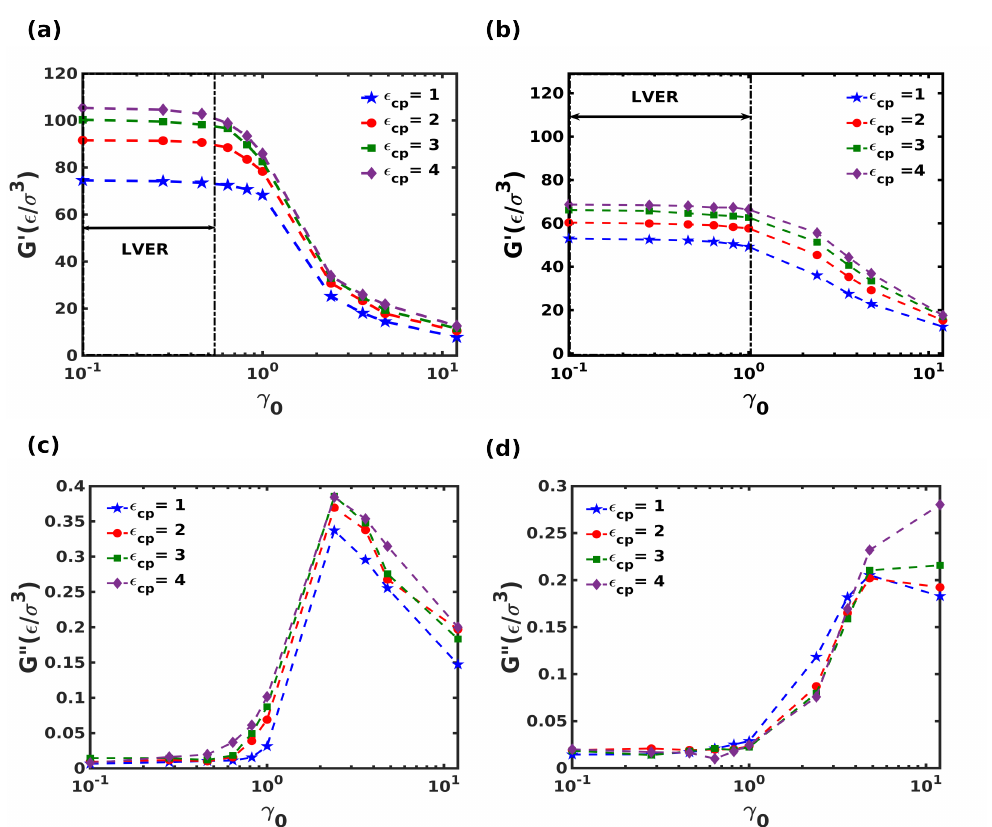
Figure 8. ( a , b ) Storage modulus ( G (cid:48) ) and ( c , d ) loss modulus ( G (cid:48)(cid:48) ) for different polymer-crystal interactions, as a function of shear amplitude for the columnar (panels ( a , c )) and the staggered (panels ( b , d )) composite